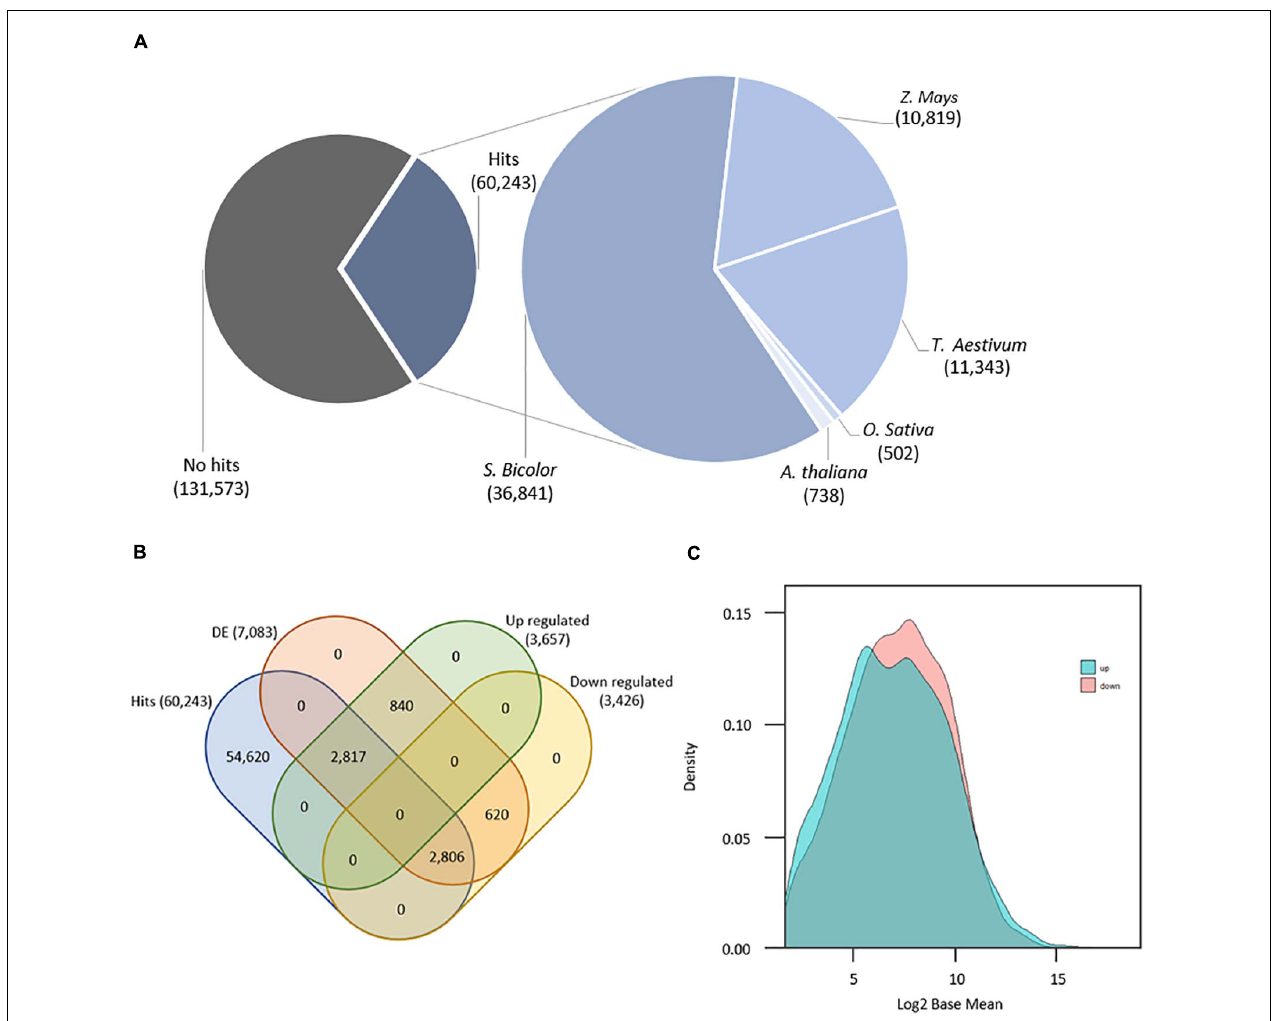
FIGURE 1 | (A) Number of annotated transcripts by organism. (B) Venn diagram with final transcript amounts after annotation and differential expression analyses. (C) Density distribution of differentially expressed genes ( n = 7,083) by basemean (x) and density